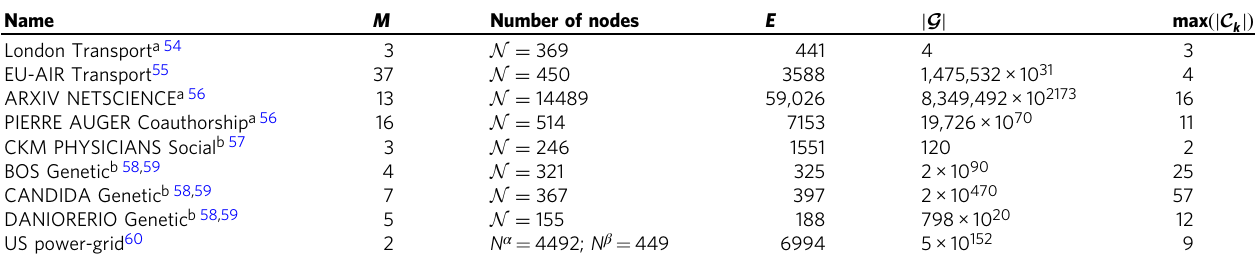
Table 1 Symmetries of real multilayer networks. For each network dataset, we include information on the number of layers M , the number of nodes in each layer N α , α = 1, … , M (the number of nodes N in all layers for multiplex networks), the number of edges E , the order of the automorphism group j G j , and the cardinality of the largest orbital cluster max ðj C k jÞ